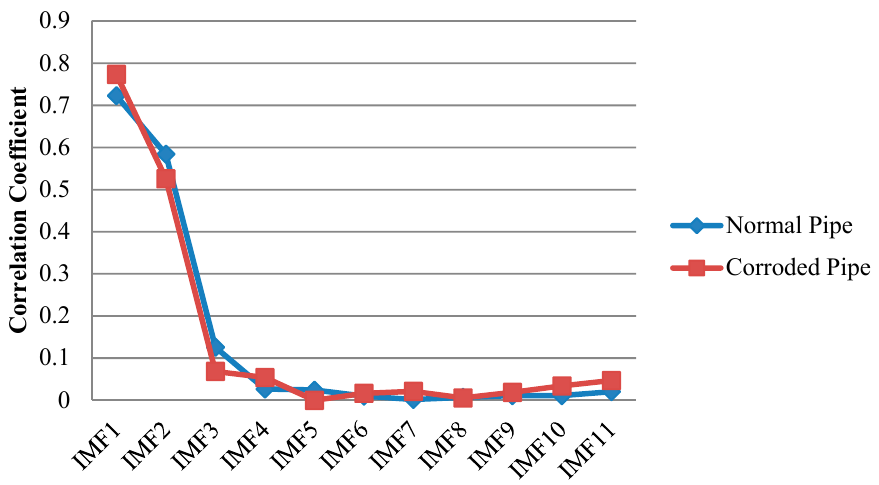
Figure 12. Absolute cross correlation of guided wave signals from pipes with their corresponding IMFs obtained from EMD.